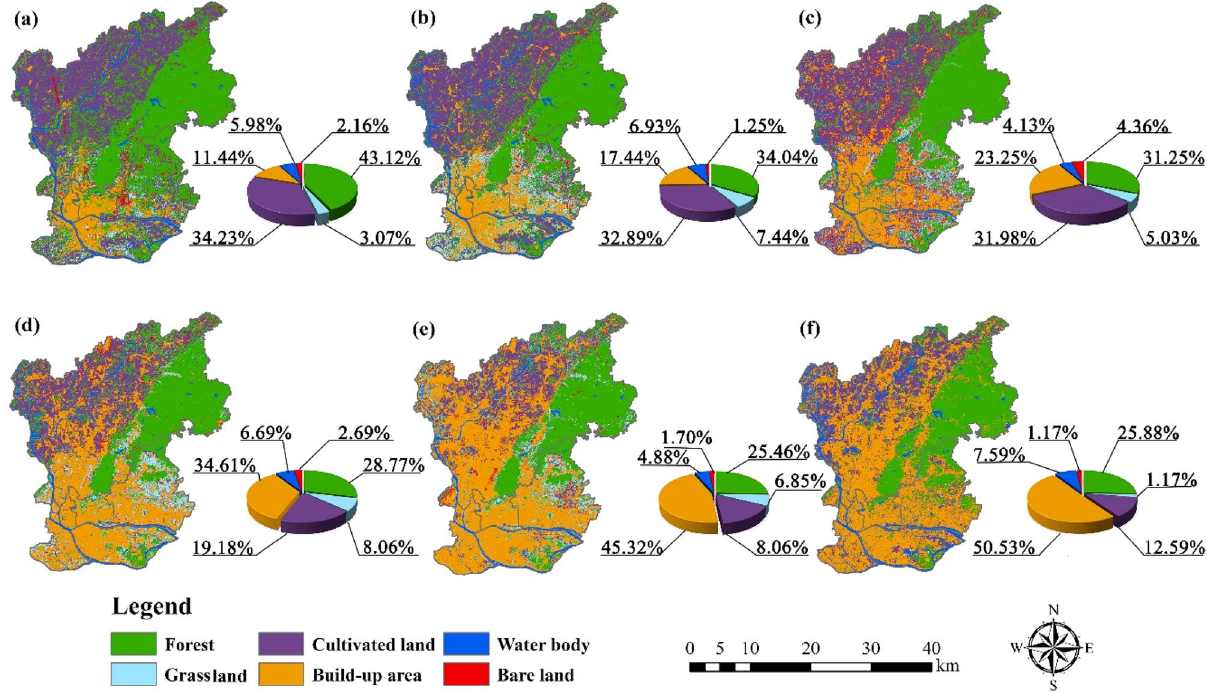
Figure 4. LULC types in the main urban area of Guangzhou from 1987 to 2017. ( a ) 1987, ( b ) 1993, ( c ) 1999, ( d ) 2005, ( e ) 2011, ( f ) 2017. (Software: Arc Map 10.5.0, http://www.esri.com. OriginPro 2017C SR2, https :// www.origi nlab.com/).